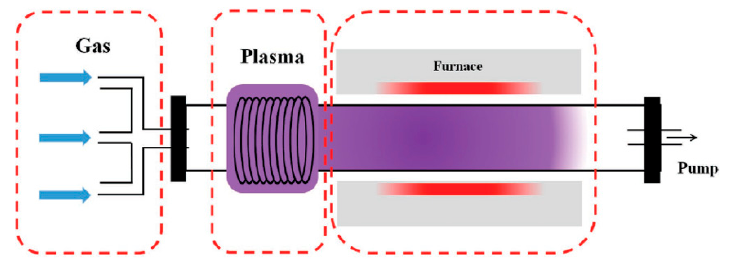
Figure 11. A schematic of a general PECVD setup (reprinted with permission from [95]).